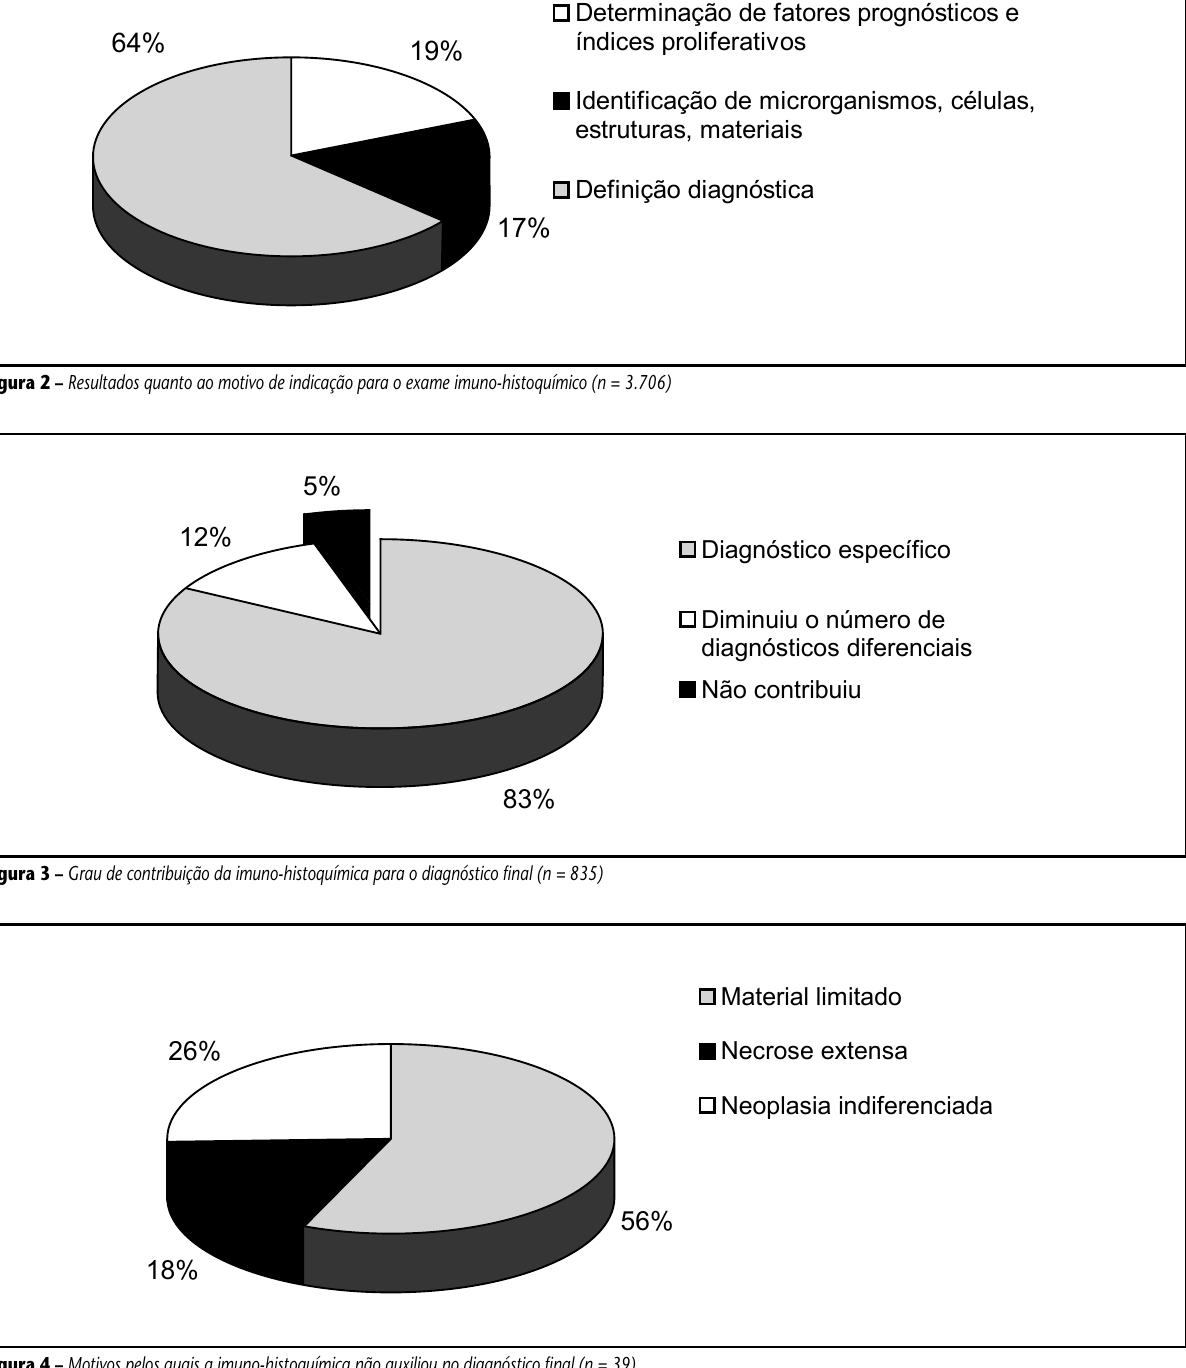
(cid:127) diferenciação entre carcinoma e linfoma: n = 59; (cid:127) diferenciação entre carcinoma e sarcoma: n =